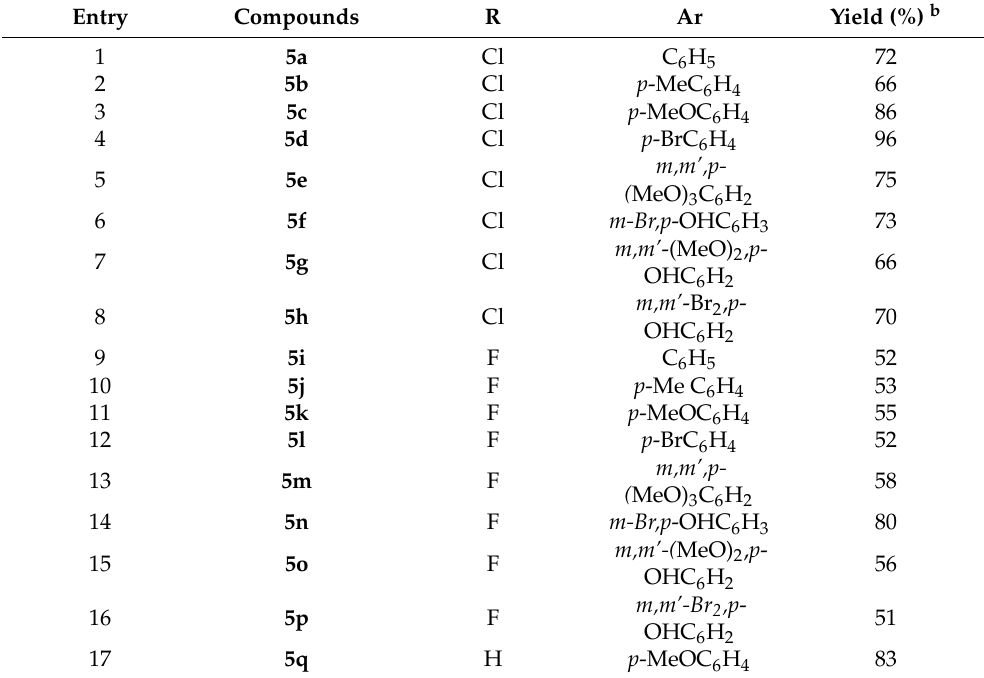
Table 2. Synthesis of the spirooxindole pyrrolidines 5 a .